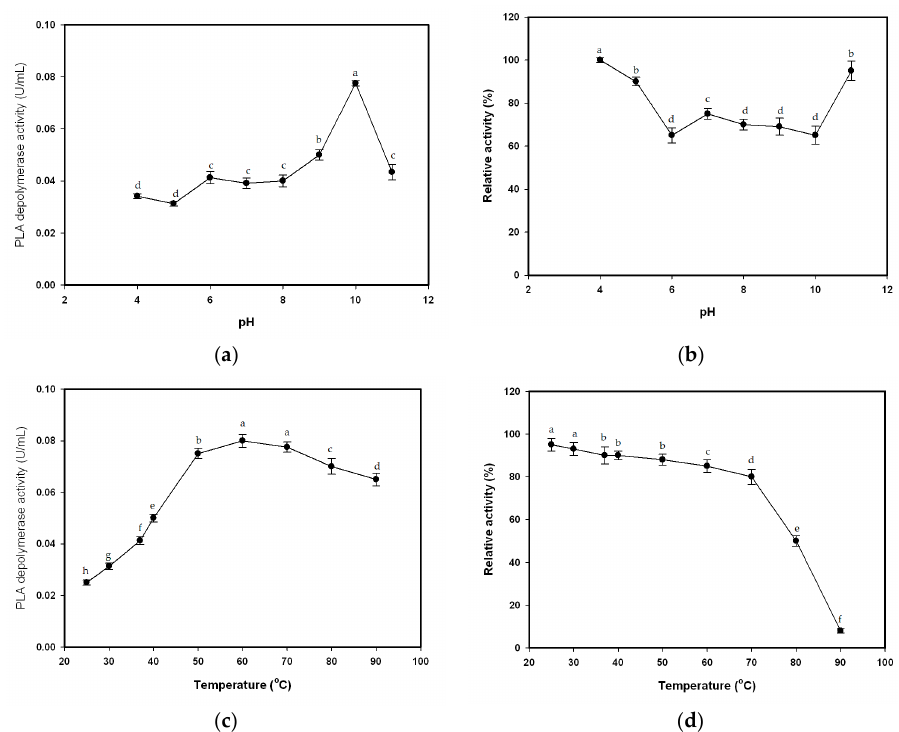
Polymers 2016 , 8 , 98 8 of 11 Figure 3. Sodium dodecyl sulphate polyacrylamide gel electrophoresis (SDS–PAGE) analysis of PLA depolymerase produced by P. tamsuii TKU015. Lanes: M, molecular markers (170, 130, 95, 72, 55, 43, 34, and 26 kDa); (1) crude enzyme; (2) adsorbed PLA depolymerase fractions after DEAE-Sepharose CL- 6B chromatography; (3) adsorbed PLA depolymerase fractions after Macro-prep DEAE chromatography; (4) PLA depolymerase fractions after Sephacryl S-100. 3.4. Effects of pH and Temperature The degradation of emulsi fi ed PLA by puri fi ed enzyme was assayed under standard conditions and pH values ranging from 4 to 11. In the pH 5–9 range, the PLA-degrading activity of the enzyme increased slightly with increasing pH (Figure 4a). The pH activity profiles of TKU015 PLA depolymerase exhibited maximum activity at pH 10 (Figure 4a). In contrast, enzyme activity is lower under acidic conditions (pH < 5; Figure 4a). The optimum pH (pH 10) for TKU015 PLA depolymerase